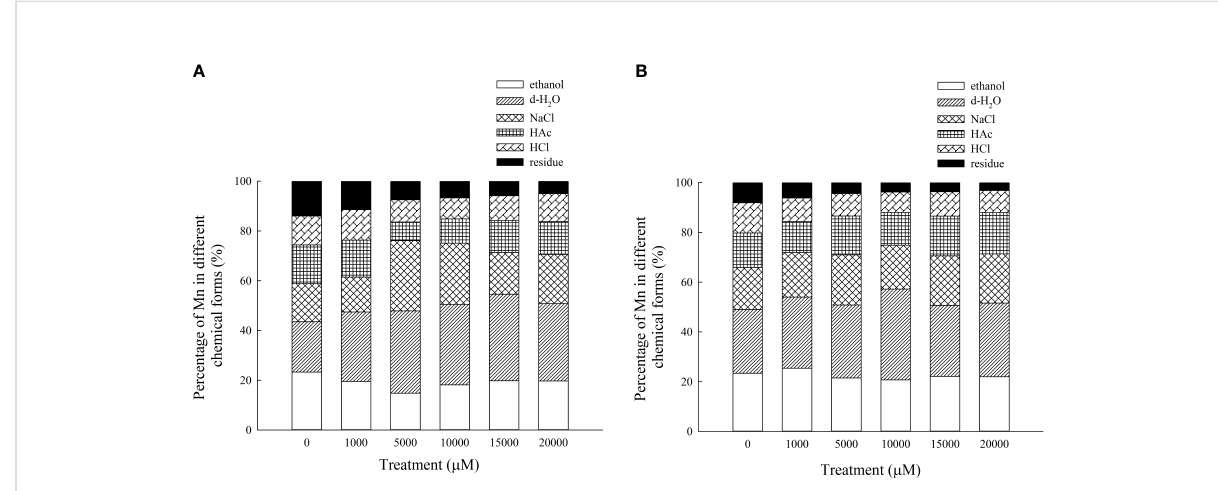
FIGURE 8 Percentages of different Mn chemical forms in aboveground part (A) and underground part (B) of D carota under different Mn